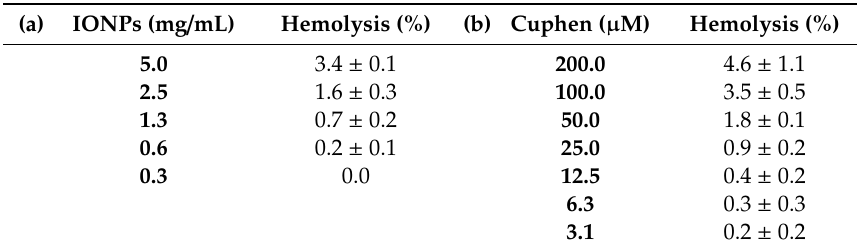
Table 3. Hemolytic activity of ( a ) free IONPs and ( b ) liposomes co-loading Cuphen and IONPs. Results are expressed as average ±